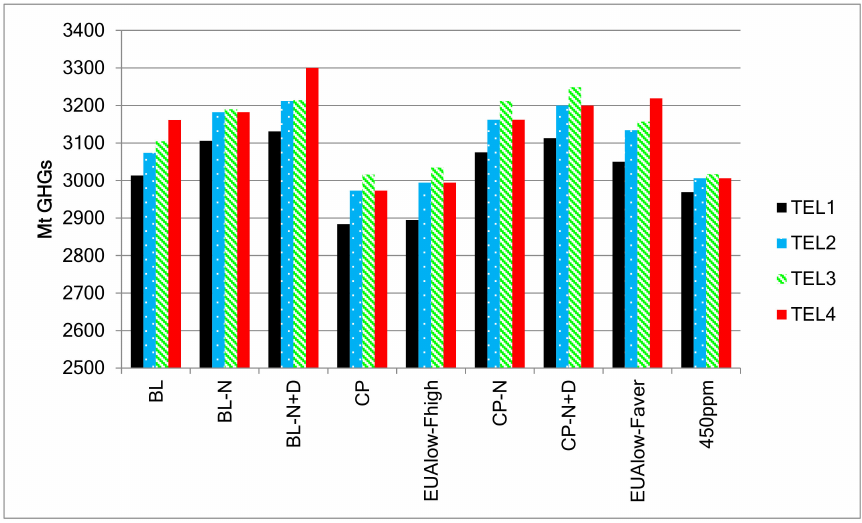
Figure 9. Cumulative GHGs emissions, Czech Republic,